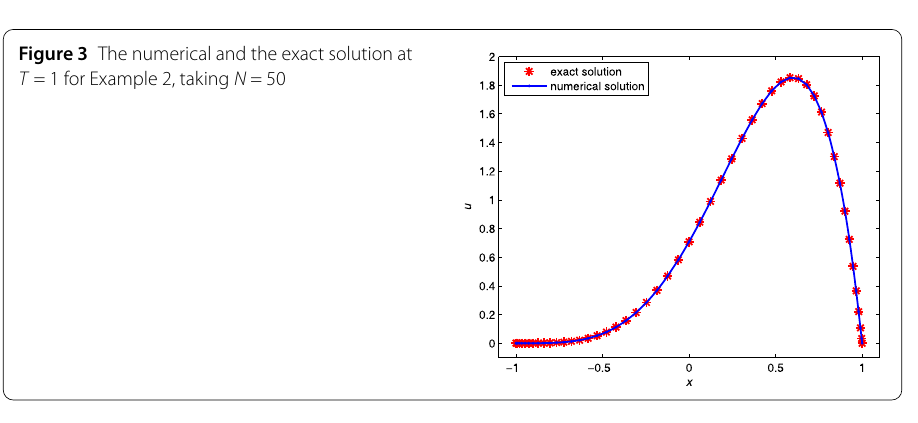
Figure 3 The numerical and the exact solution at T = 1 for Example 2, taking N =